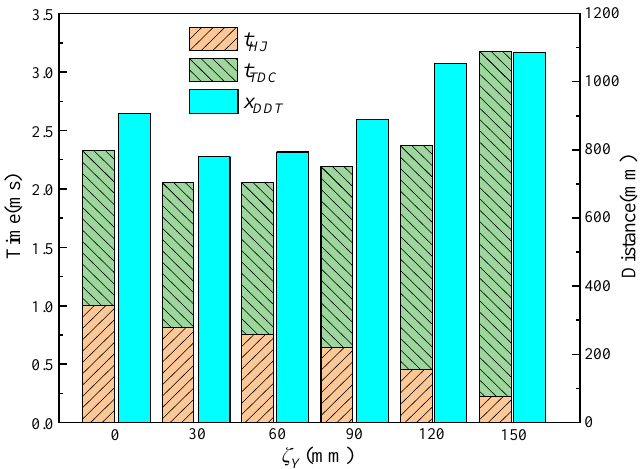
Figure 20. DDT distance and time of different ignition positions.